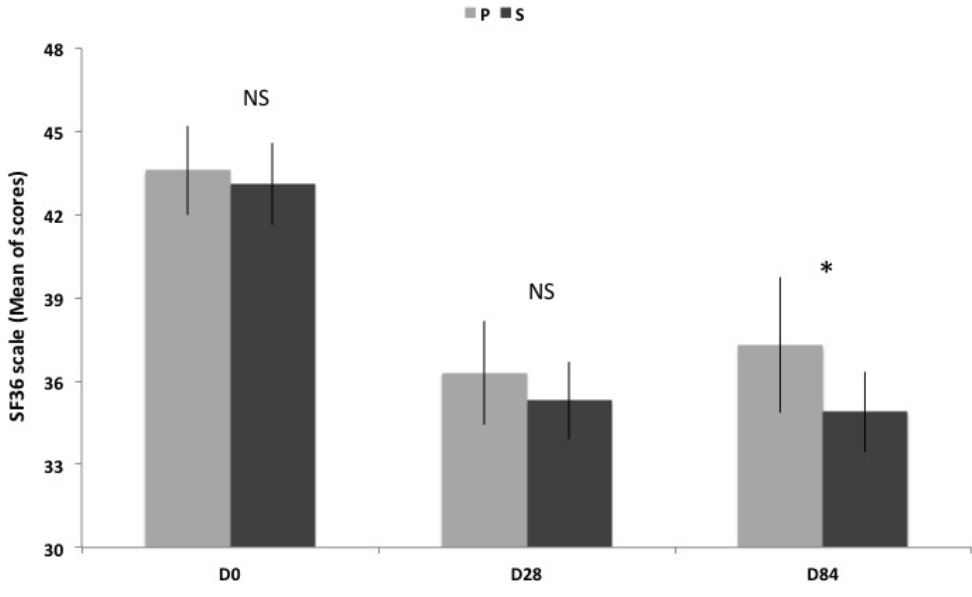
Figure 2. Scores of SF 36 scale (Mean ± SEM) before, between and after supplementation. Transverse comparison between groups are not significantly different (NS) for D0 and D28, but significantly different (* p < 0.05) for